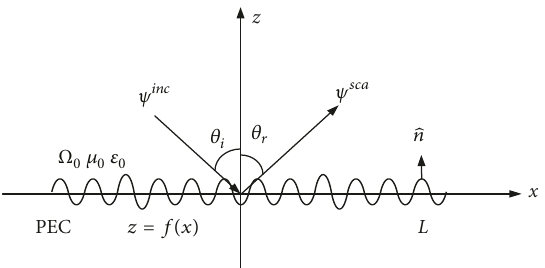
Figure 1: Geometric model of the EM scattering from a PEC rough